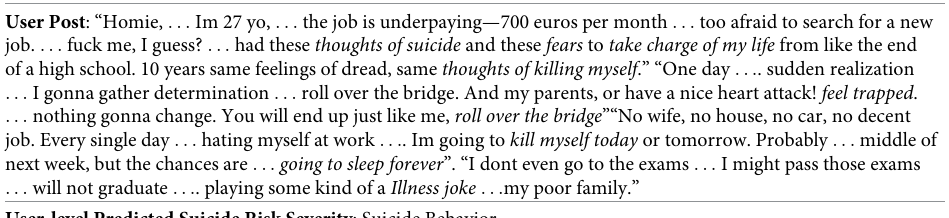
Table 3. Example posts from a user( u i ) and prediction from TinvM. The italicized text are phrases which contrib- uted to the representation of the post. These phrases had similarity to the concepts in medical knowledge bases. User Post : “Homie, ... Im 27 yo, ... the job is underpaying—700 euros per month ... too afraid to search for a new job. ... fuck me, I guess? ... had these thoughts of suicide and these fears to take charge of my life from like the end of a high school. 10 years same feelings of dread, same thoughts of killing myself .” “One day ... . sudden realization ... I gonna gather determination ... roll over the bridge. And my parents, or have a nice heart attack! feel trapped . ... nothing gonna change. You will end up just like me, roll over the bridge ”“No wife, no house, no car, no decent job. Every single day ... hating myself at work ... . Im going to kill myself today or tomorrow. Probably ... middle of next week, but the chances are ... going to sleep forever ”. “I dont even go to the exams ... I might pass those exams ... will not graduate ... . playing some kind of a Illness joke ... my poor family.”